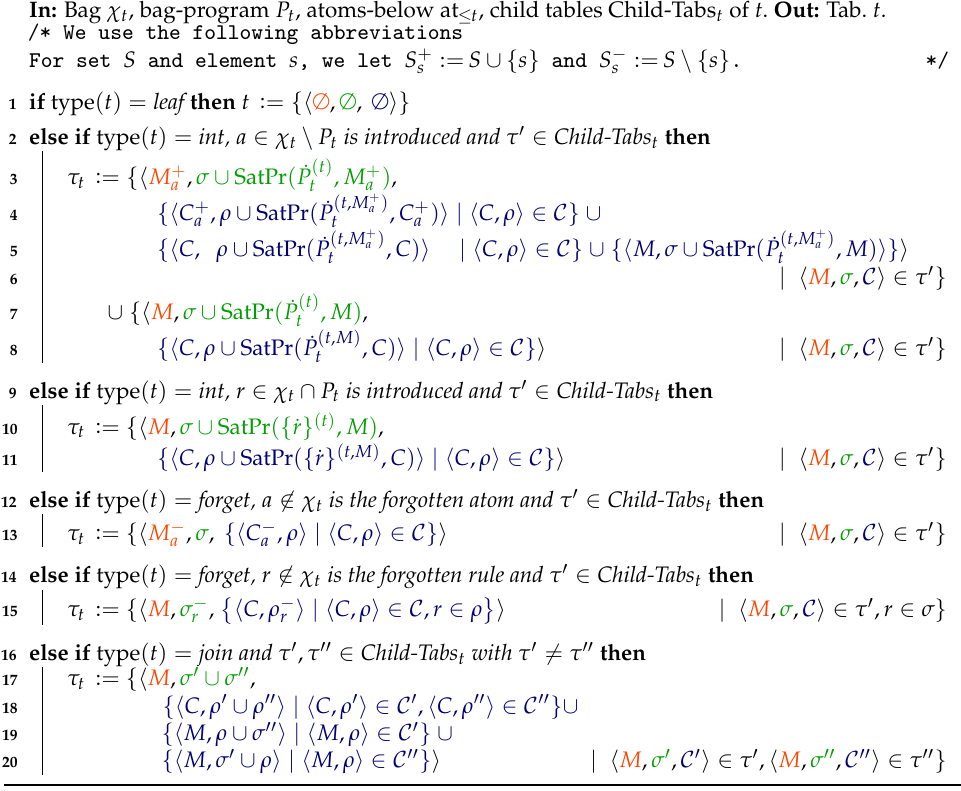
Algorithm 2: Table algorithm SINC ( t , χ t , P t , at ≤ t , Child-Tabs t ) . In: Bag χ t , bag-program P t , atoms-below at ≤ t , child tables Child-Tabs t of t . Out: Tab. t . /* We use the following